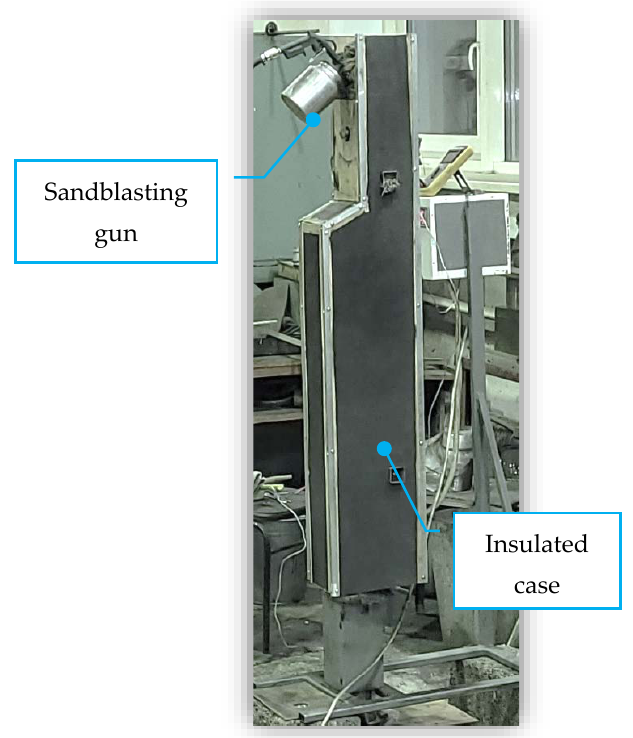
Figure 3. The experimental bench in the insulated exterior casing.